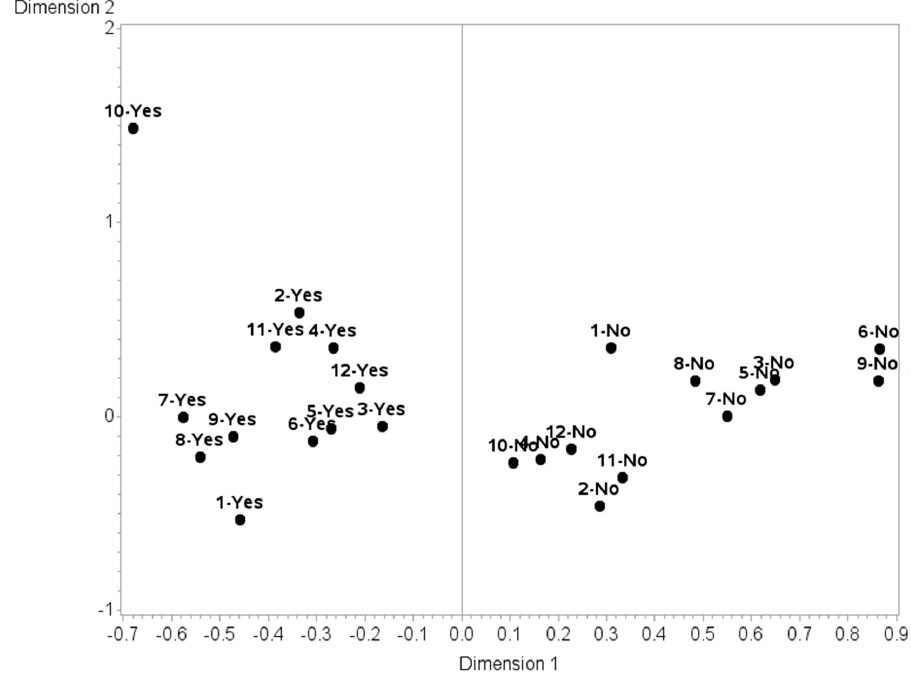
Figure 2. Projection of the active variables in the MCA. Legend: For all variables, “Yes” and “No” represents responses indicating that people adopt or do not adopt, respectively, the following behaviours: 1. Cover your head in strong sunlight; 2. Take showers or baths more often than usual; 3. Drink mainly plain water to cool down; 4. Swim in a public or private place during high heat and humidity; 5. Adopt behaviours according to weather bulletins; 6. Use window shades to block strong sunlight and keep the home cool; 7. Use the dryer less; 8. Shut off the computer when not in use; 9. the evening; 12. Keep a list of emergency phone numbers on